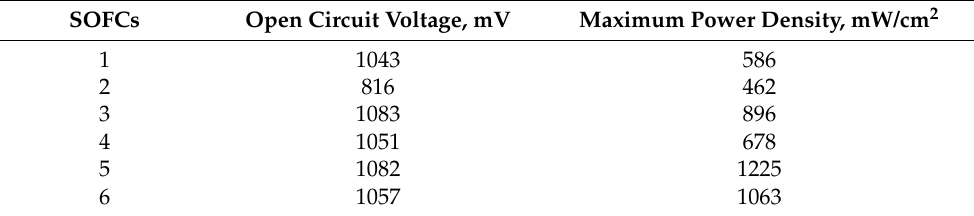
Table 2. Parameters of SOFCs with thin film YSZ electrolyte at 800 ◦ C. SOFCs Open Circuit Voltage,